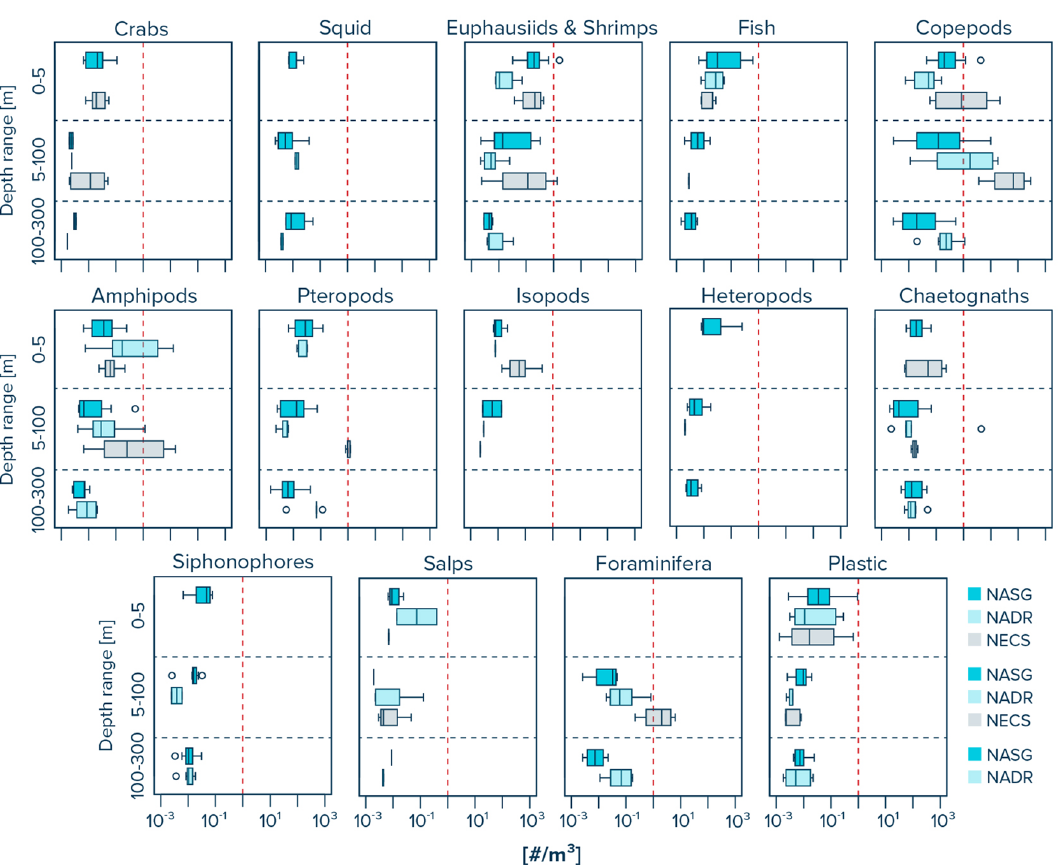
Figure 4. Observed water column distribution of marine organisms for three specific water layers (i.e., 0–5 m, 5–100 m and 100–300 m) in the North Atlantic Subtropical Gyre (NASG), the North Atlantic Drift Region (NADR), and the Northeast Atlantic Continental Shelves (NECS). Solid vertical lines represent median values. Box plots extend from the 25th to the 75th percentiles, while whiskers extend from the minimum to the maximum observed values. Dots indicate outliers. Red dashed vertical line represents x-axis value of 1 for better visual comparison between the taxa. Note that all values are provided in Supplementary Table